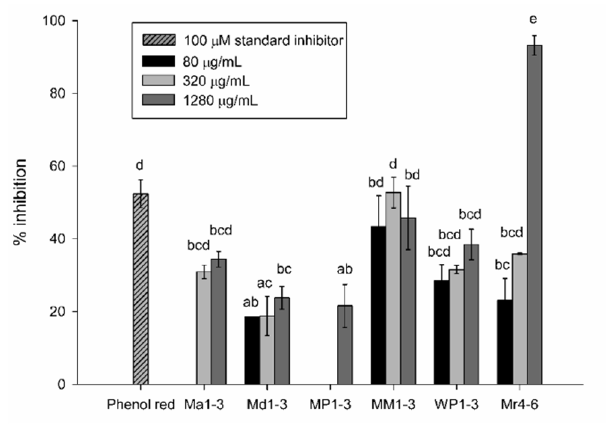
Figure 2. Percentage inhibition of Aβ42 (1-42) aggregation of Mentha australis (Ma1-3), M. diemenica (Md1-3), M. spicata var. crispa (MM1-3), M. × piperita (MP1-3), M. × piperita var. officinalis (WP1-3) and M. requienii (Mr4-6). Results are presented as mean ± standard error (SE) ( n = 3). Different letters indicate a significant difference at p < 0.05. 80 µg/mL Ma1-3 and 80 µg/mL and 320 µg/mL MP1-3 resulted in no inhibition.